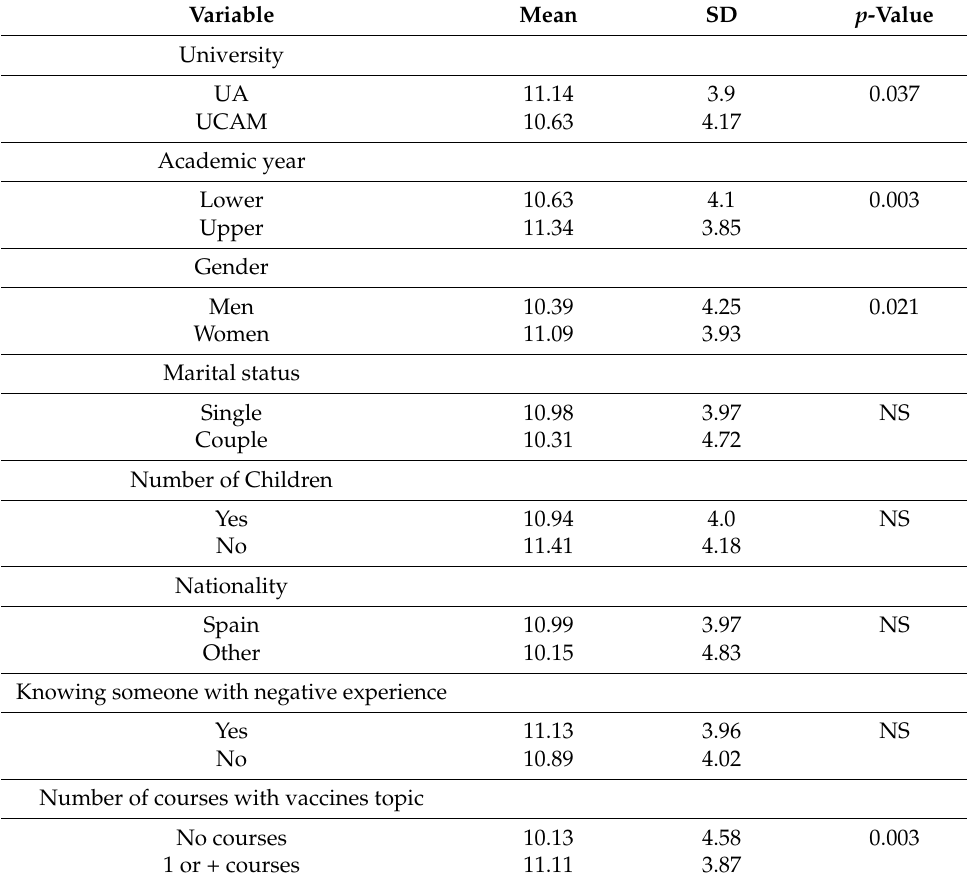
Table 6. Knowledge regarding health professionals’